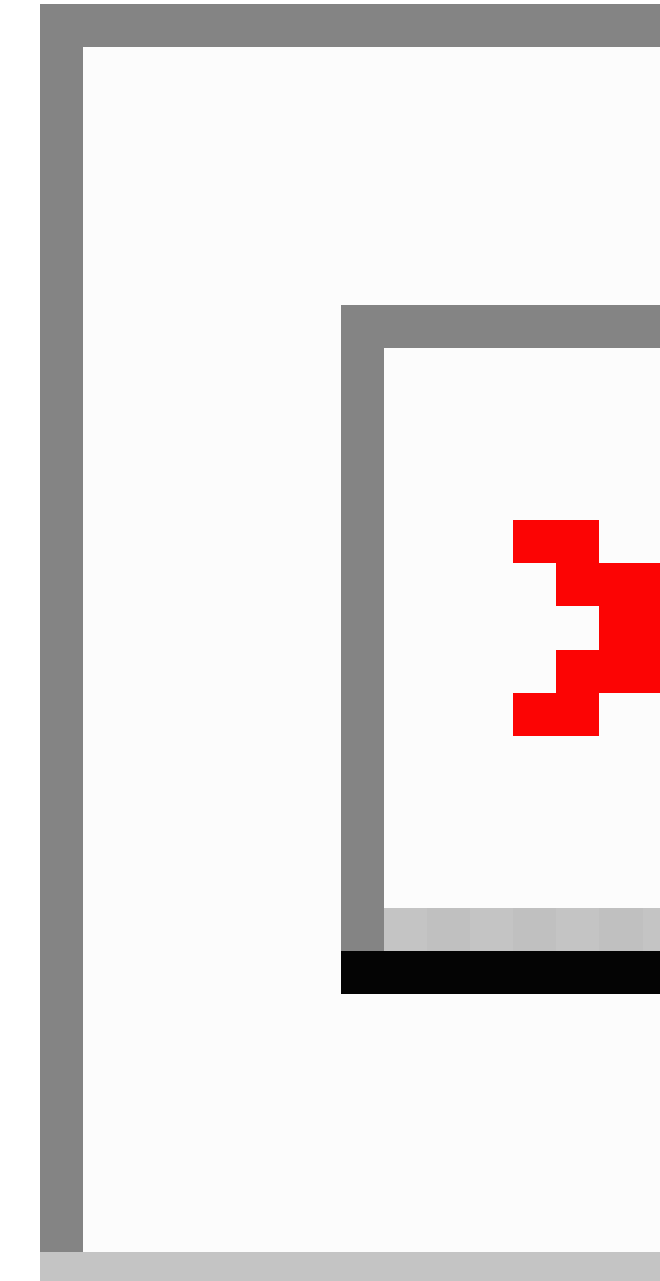
Figure 2. Diagram of the data-flow within the PPAP